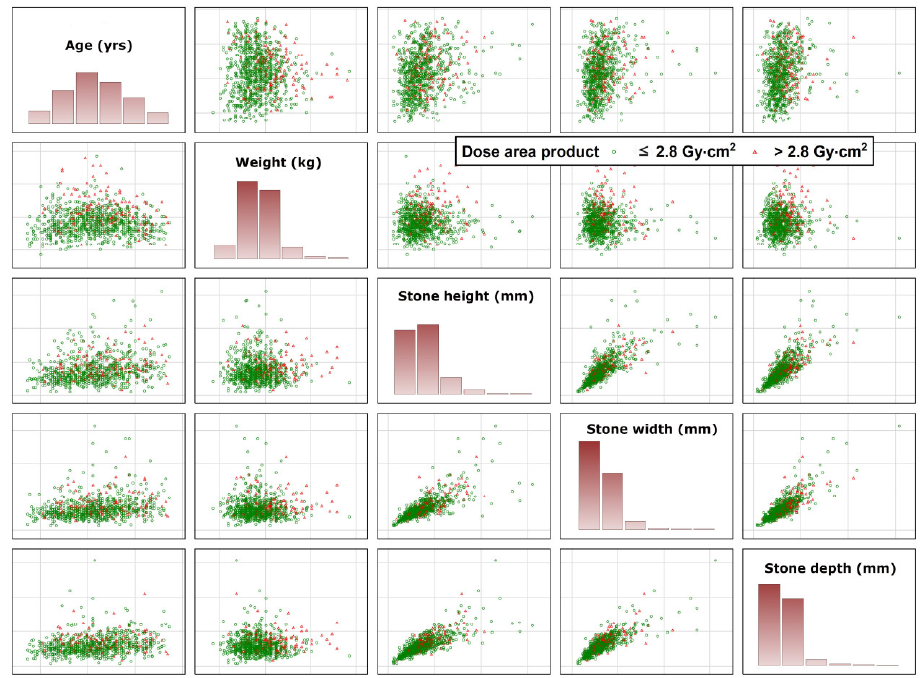
Figure 3. Illustration how close patients with a low DAP and high DAP are stuck together when only some of the predictors without using any reject option are used for separation. Results illustrate a considerable overlap between both groups and the need for application of the reject option. Green circles illustrate patients with low DAP doses, red triangles does with large DAP.